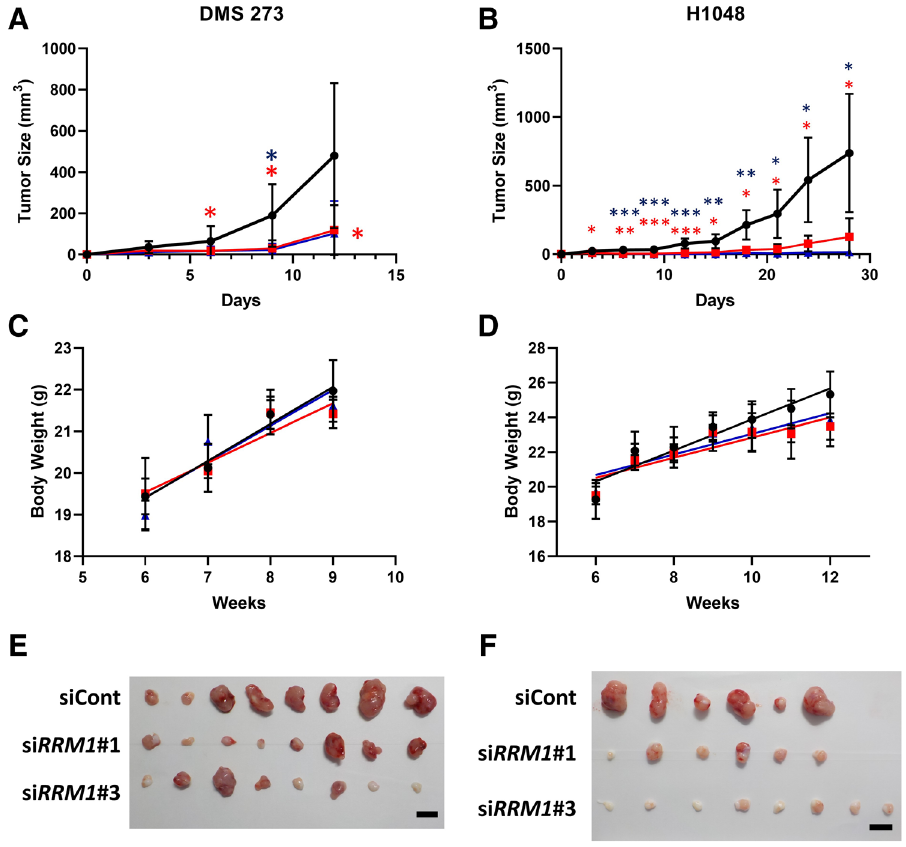
Figure 3. RRM1 regulates tumor progression in an SCLC xenograft mouse model. ( A ) and ( B ), in vivo growth of SCLC DMS 273 ( A ) and H1048 ( B ) cell tumors in nude mice transfected and injected with siRNA every 3 days ( n = 6–8). siCont: black, si RRM1 #1: red, si RRM1 #3: blue. * p < 0.05; ** p < 0.01, *** p < 0.005 vs. control, Dunnett’s multiple comparisons test. C and D , body weight of mice transplanted with 273 ( C ) and H1048 cells ( D ). siCont: black, si RRM1 #1: red, si RRM1 #3: blue. Data represent the mean ± SD ( n = 3–4). E and F , gross tumor pathology in tumors derived from 273 ( E ) and H1048 cells ( F ) at the end of the experiments. Scale bars = 10